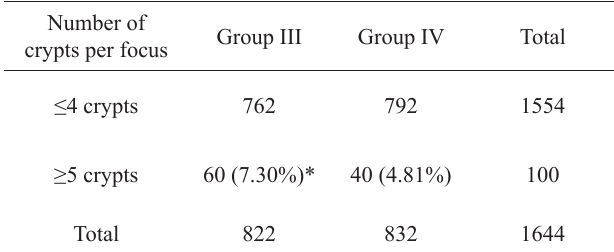
TABLE 7 - Number of ACF with ≤4 crypts and ACF with ≥5 crypts in Groups III and